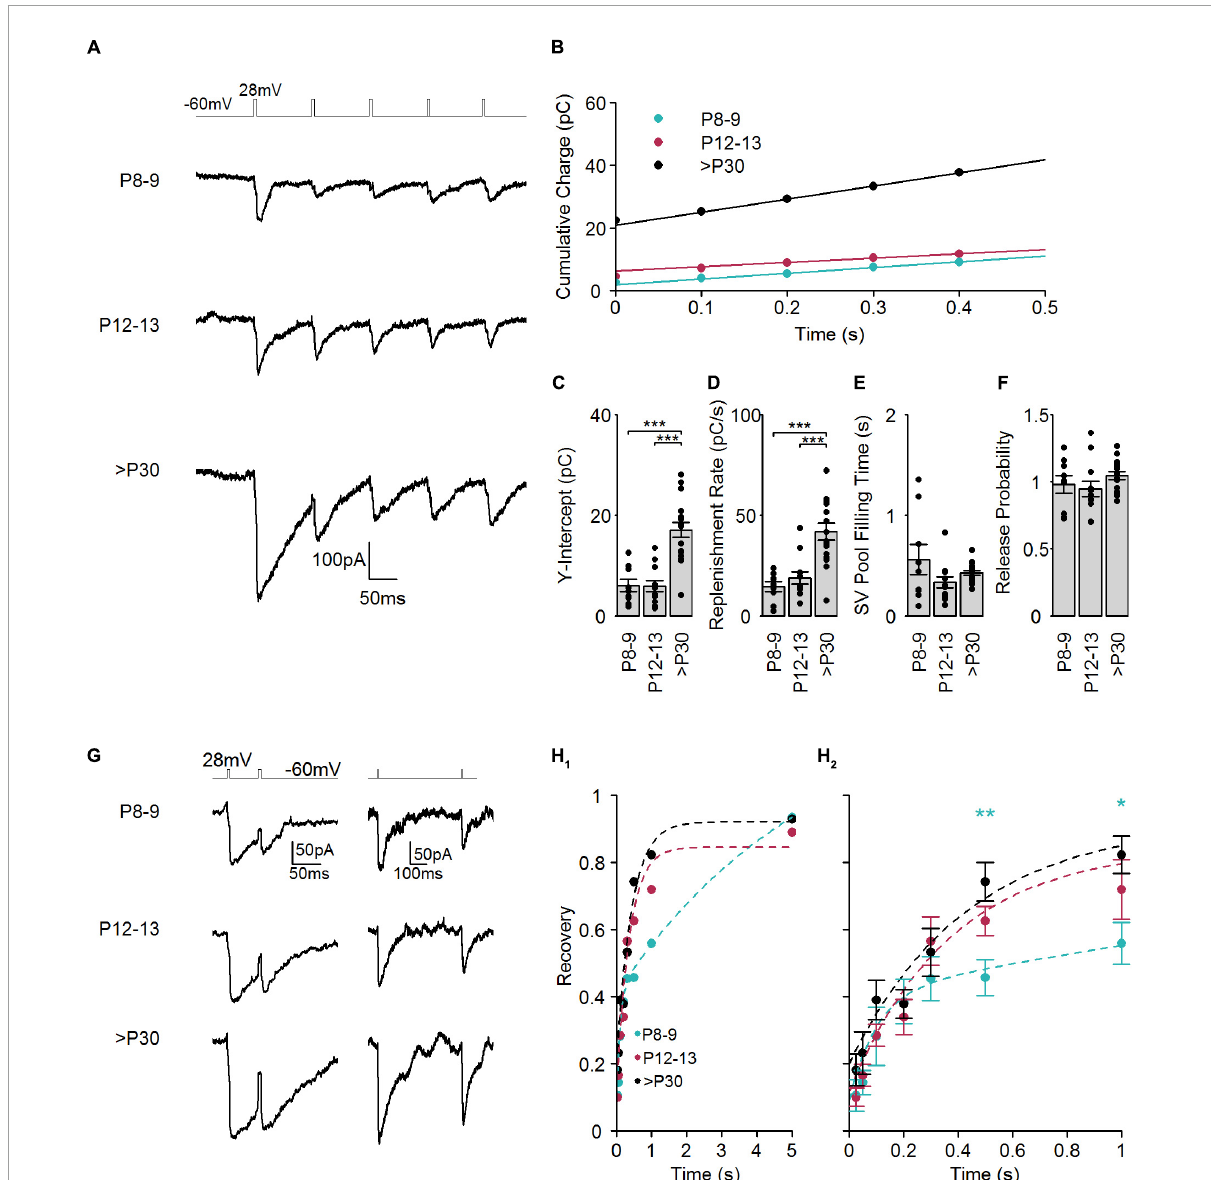
FIGURE5 SV replenishment and recovery from synaptic depression during postnatal development. (A) Representative traces of I AGlu events evoked by five sequential step depolarizations (–60 to 28 mV, 5 ms) at a frequency of 10 Hz at the different developmental stages. (B) Cumulative charge transfer of I AGlu events at the different developmental stages. Lines are linear fits to the 0.2–0.4 ms region, which were extrapolated to the Y -axis. (C) RRP, calculated from the Y-intercept of the linear fits ( p < 0.001, n = 9–17 cells, one-way ANOVA test). Post hoc Tukey Test (P8–9 vs. P12–13: p = 0.997, P8–9 vs. > P30: p < 0.001, P12–13 vs. > P30: p < 0.001). (D) The rate of SV replenishment calculated from the slope of the linear fits ( p < 0.001, n = 9–17 cells, one-way ANOVA test). Post hoc Tukey Test (P8–9 vs. P12–13: p = 0.75, P8–9 vs. > P30: p < 0.001,